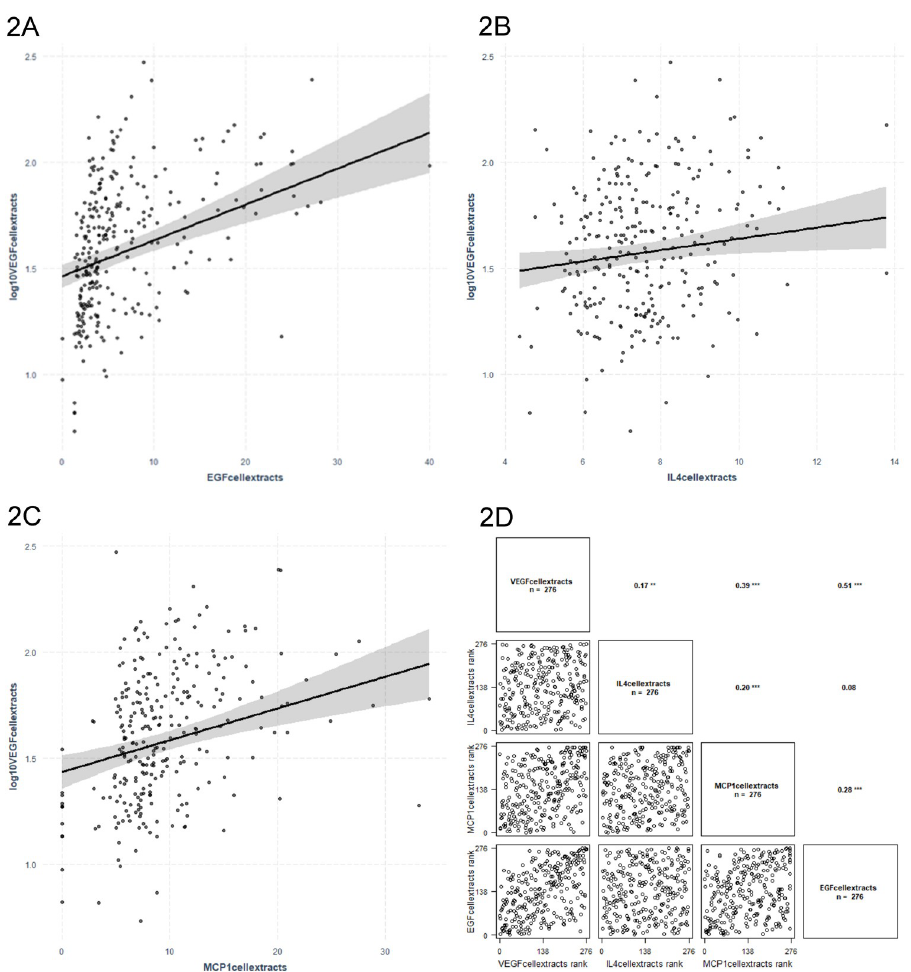
Fig 2. Regression graphs for VEGF protein levels (VEGF cellular extracts) as dependent variable and EGF (2A), IL-4 (2B) and MCP1 (2C) cellular extracts levels as independent variables. The related correlation graph is presented in (2D). ‘ ��� ’ p � 0.001, ‘ �� ’ p � 0.01.